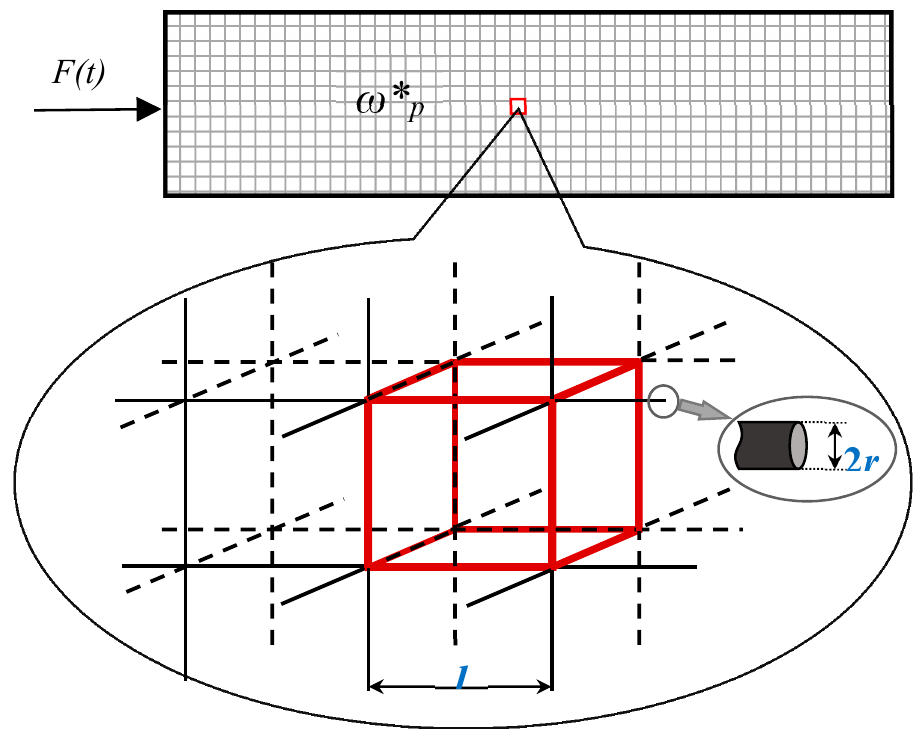
Figure 4. Metallic wires with a radius of r arranged in a simple cubic lattice with the lattice constant l . The lattice is subjected to the axial sinusoidal force F ( t ) = ˆ Fsin ω .